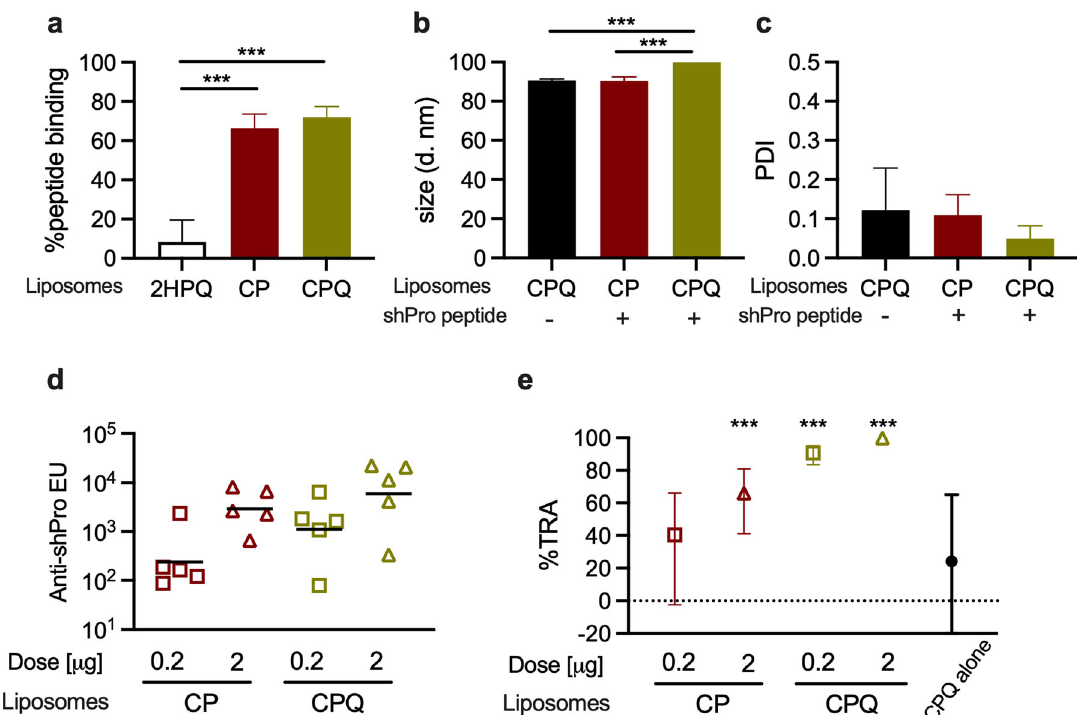
Fig. 6 The shPro peptide formulated with CP or CPQ adjuvants elicits potent functional antibodies. a The percentage of peptide binding to liposomes as assessed by a microcentrifugal fi ltration assay. The details of 2HPQ (a negative control), CP and CPQ (CP plus QS-21) liposomes are described in the Methods section, and the mean + standard deviation (SD) for n = 4 experiments are shown. There was a signi fi cant difference among the three groups ( p < 0.001 by a one-way ANOVA test). The signi fi cant differences between two groups judged by Dunn ’ s multiple comparisons tests are shown. *** p < 0.001. The size ( b ) and Polydispersity Index (PDI, c ) of liposomes before and after peptide incubation. The mean + SD for n = 3 experiments are shown. There was a signi fi cant difference in size ( p < 0.001), but not in PDI ( p = 0.466). d A group of fi ve mice were immunized with a 0.2 or 2 µg dose of shPro peptide (without KLH-conjugation) formulated with CP or CPQ liposomes. Antibody levels in individual mice against shPro peptide are shown with the geometric mean of the group (bars). e The functional activity of total IgGs was evaluated in two independent SMFA assays with human complement at 1.5 mg/mL. In addition, a puri fi ed total IgG from mice immunized with CPQ alone was tested at the same condition in SMFA. The %TRA and the 95% CI are shown. *** p <